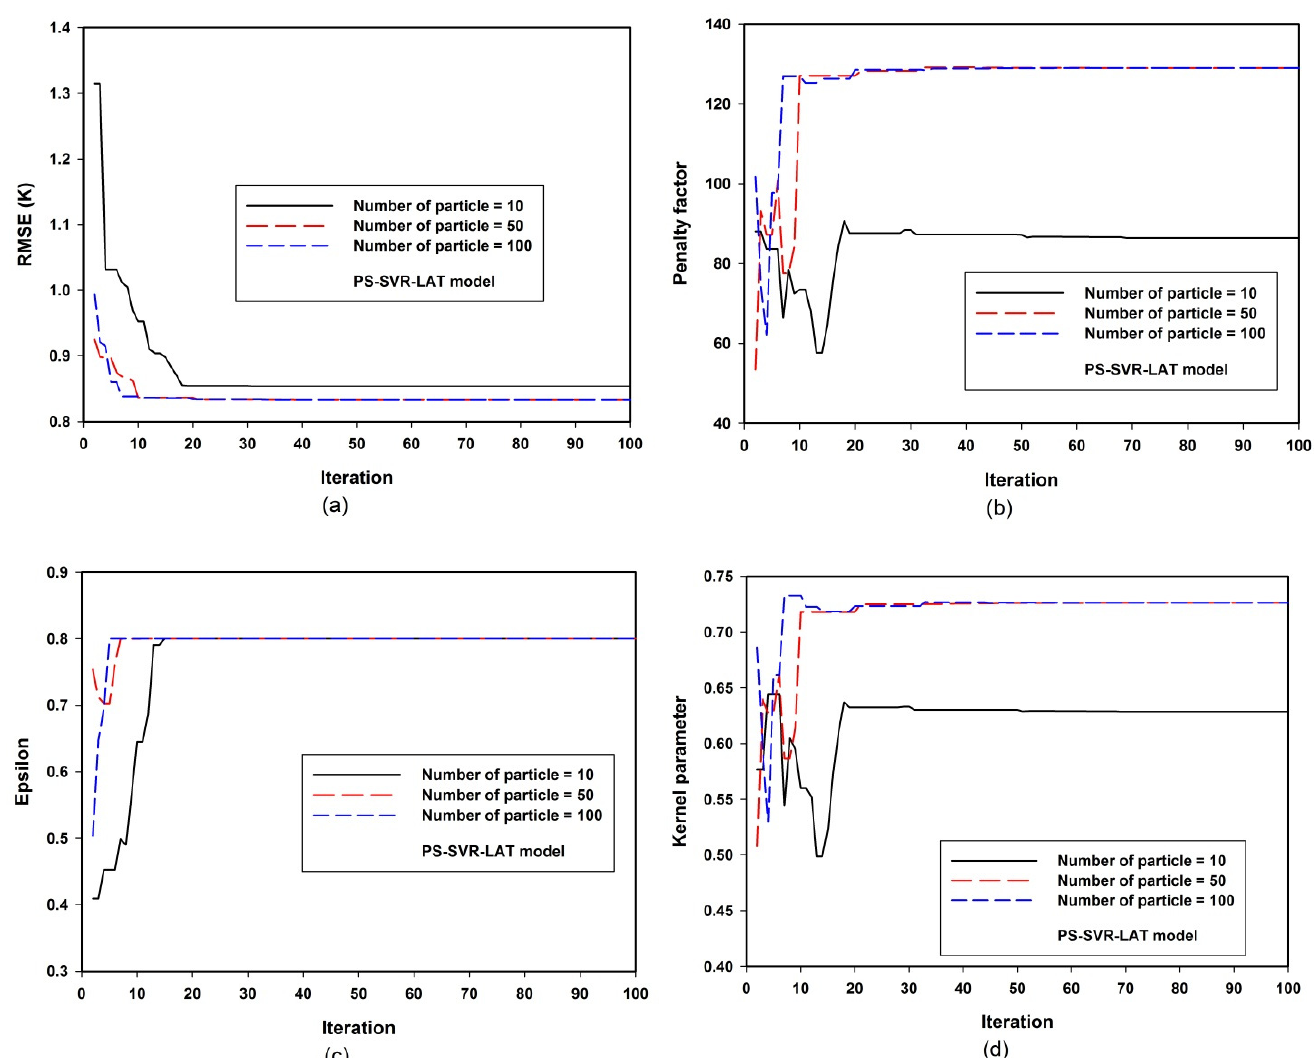
Figure 2. Convergence and PS-SVR-LAT model sensitivity to hyper-parameters. ( a ) PS-SVR-LAT model sensitivity to root mean square error(RMSE) at various population size ( b ) PS-SVR-LAT model sensitivity to penalty factor at various population size ( c ) PS-SVR-LAT model sensitivity to epsilon at various population size ( d ) PS-SVR-LAT model sensitivity to kernel parameter at various population size.